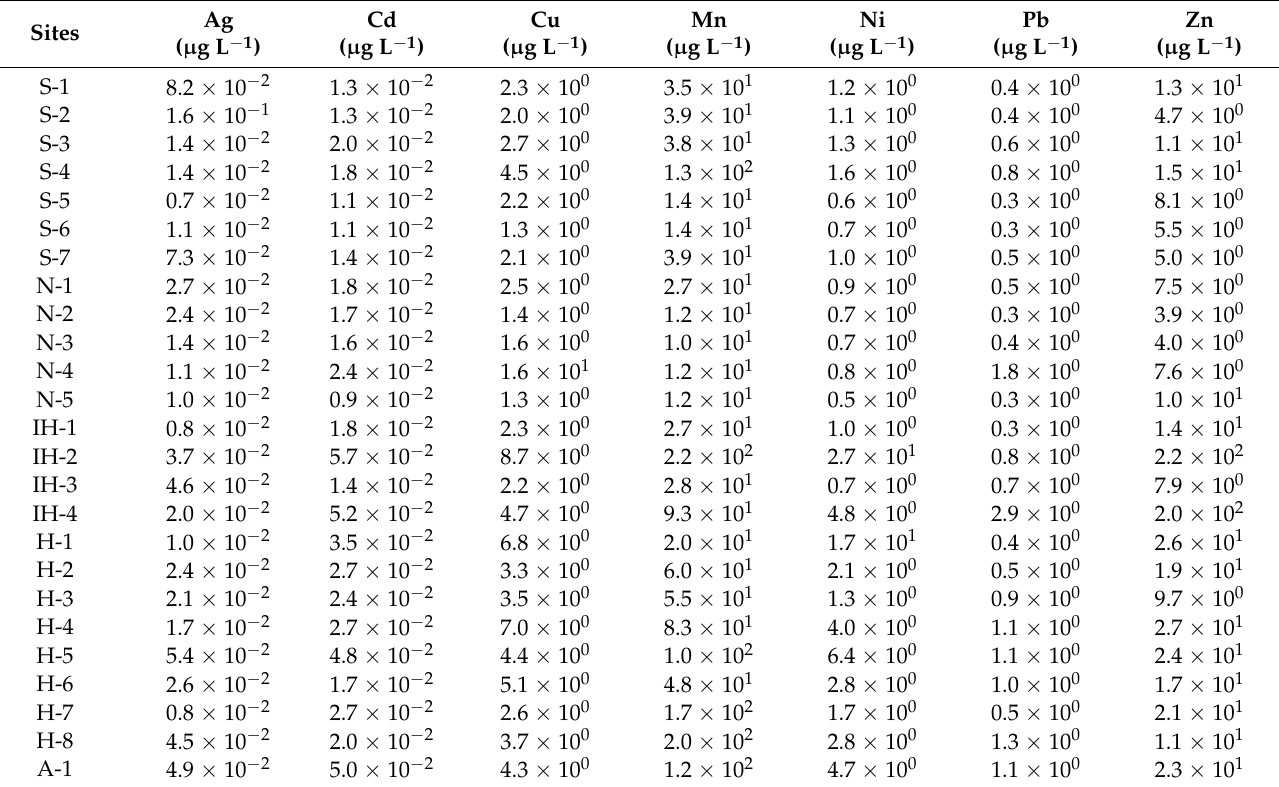
Table 2. Summary of heavy metal concentrations at each site of the Han River watershed.